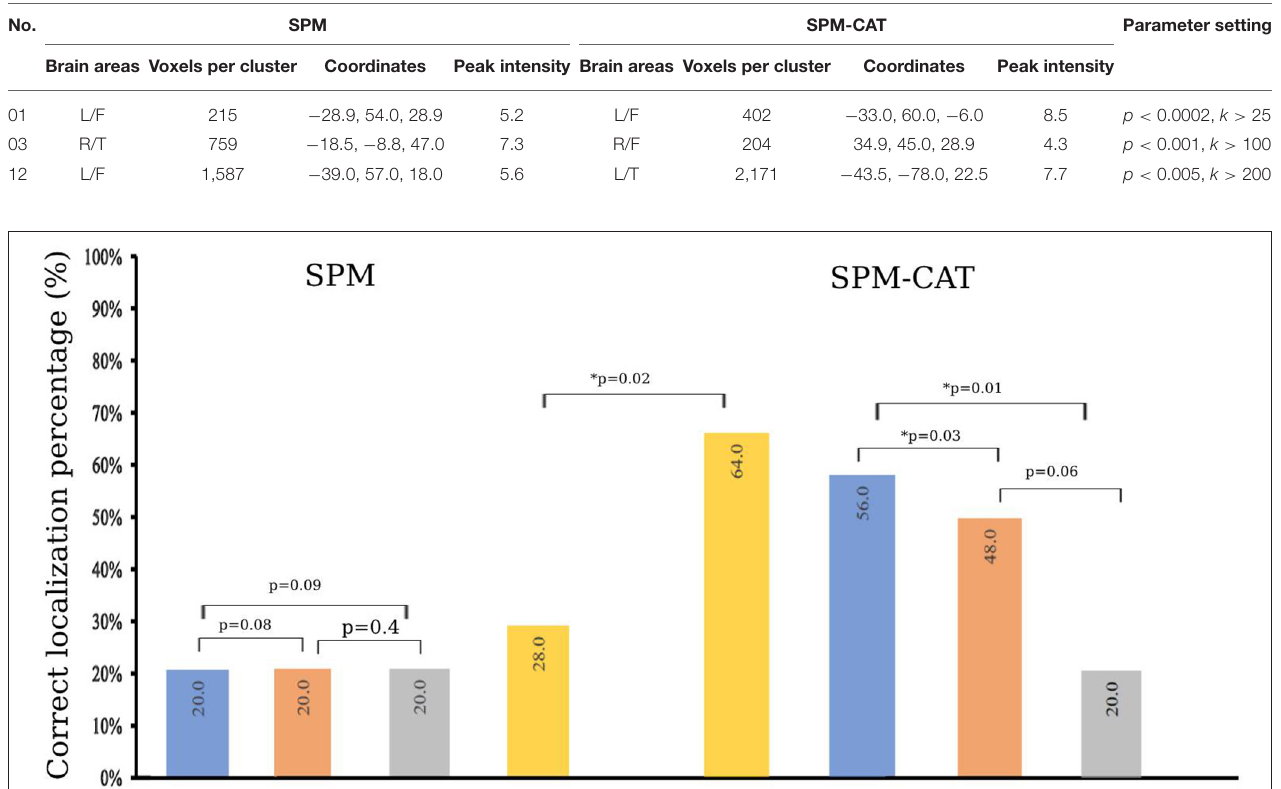
FIGURE 4 | Positive finding score of SPM and SPM-CAT with different parameter settings ( p -value is from McNemar’s